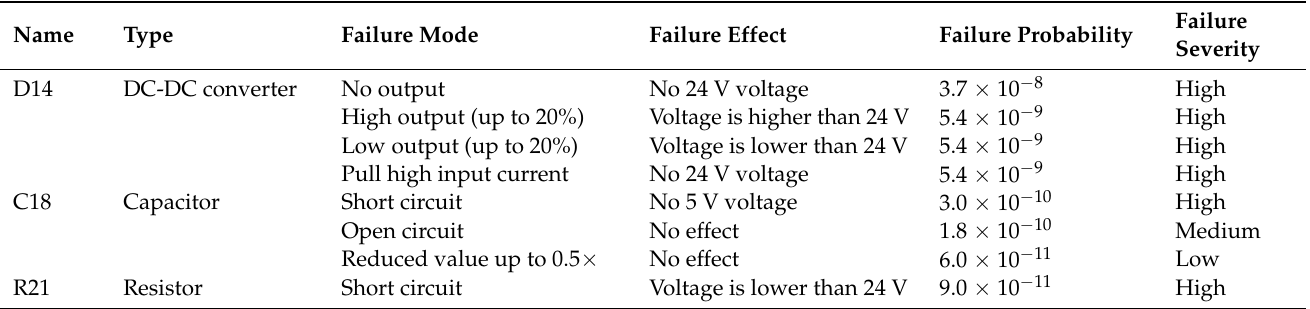
Table 11. FMECA table after ScW